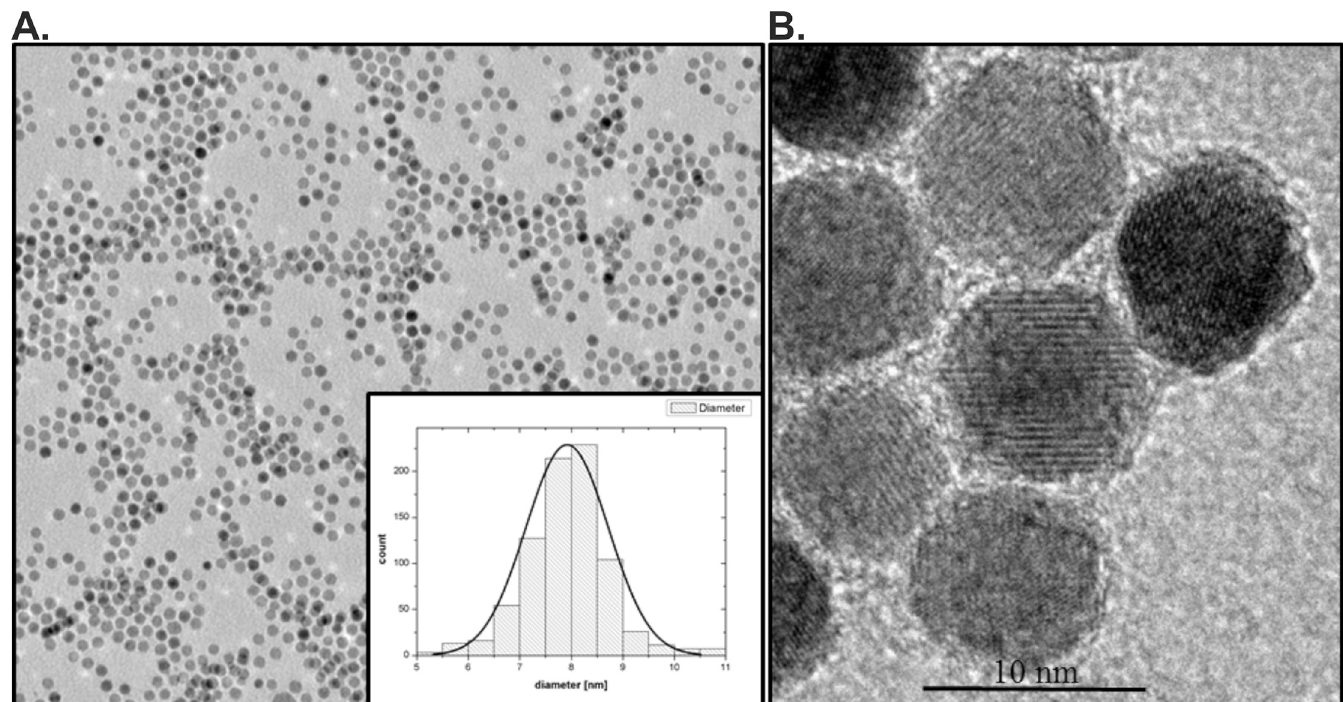
Fig 1. TEM characterization of iron oxide nanoparticles. A) TEM image by low magnification with inserted size distribution of IONPs, B) HRTEM image that shows the ultrastructure and morphology of Fe 3 O 4 nanoparticles.